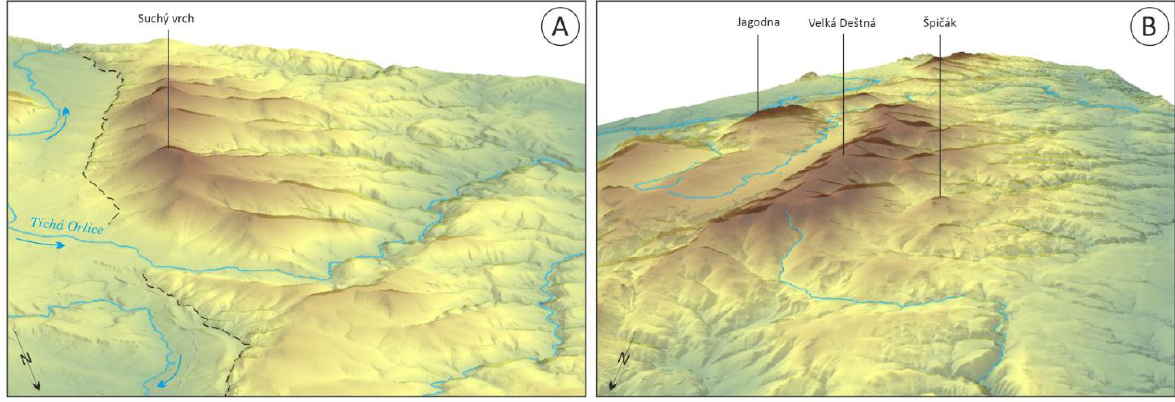
Figure 8. Large-scale topography of the Orlické–Bystrzyckie Mountains Block on 3D visualizations: ( A ) view from SSE; ( B ) view from NNW; ( C ) view from SW. Explanations: 1–3—three main geomorphic units of OBMB: 1—the most elevated northern part, with the main ridge of the Orlické Mts. (1a) and downfaulted steps of the Bystrzyckie Mts. (1b to 1d), 2—least elevated central part, 3—Suchý vrch massif; fluvial gorges: 1—Peklo, 2—Zemská brána (Divoká Orlice water gap), 3—Tichá Orlice water gap; broken lines—footslopes of fault-generated escarpments.